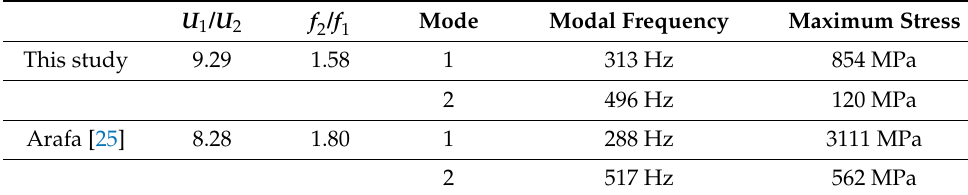
Table 2. Comparison of the Bézier-profiled plate with the trapezoidal plate.